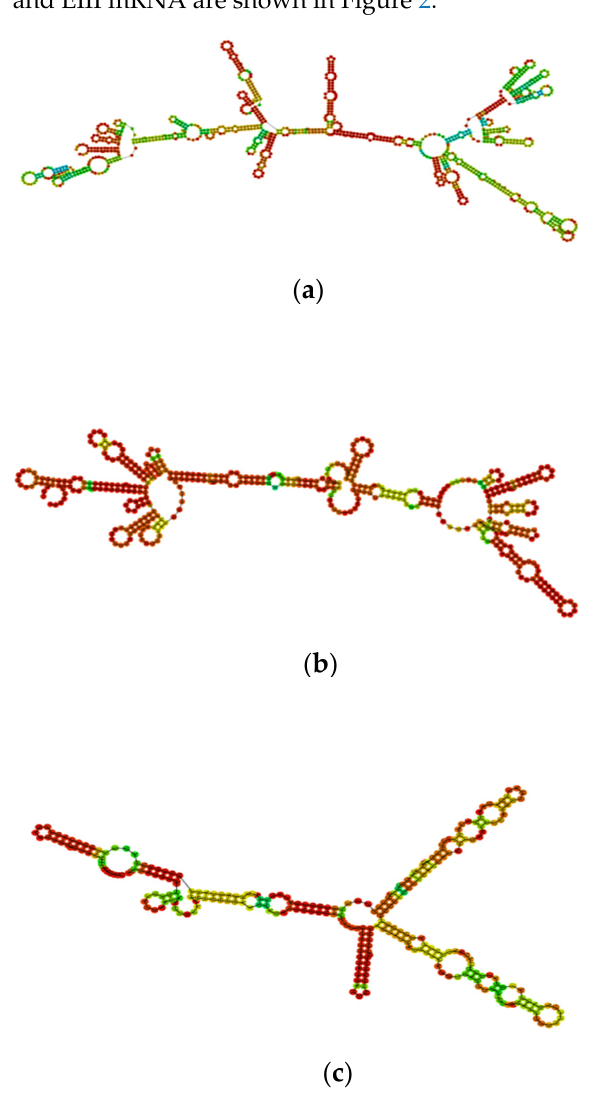
Figure 2. The secondary structures of optimized ( a ) NS1 mRNA; ( b ) prM mRNA; ( c ) EIII mRNA were predicted by the RNAfold server. The structure is colored by base-pairing probabilities. For unpaired regions, the color denotes the probability of being unpaired.